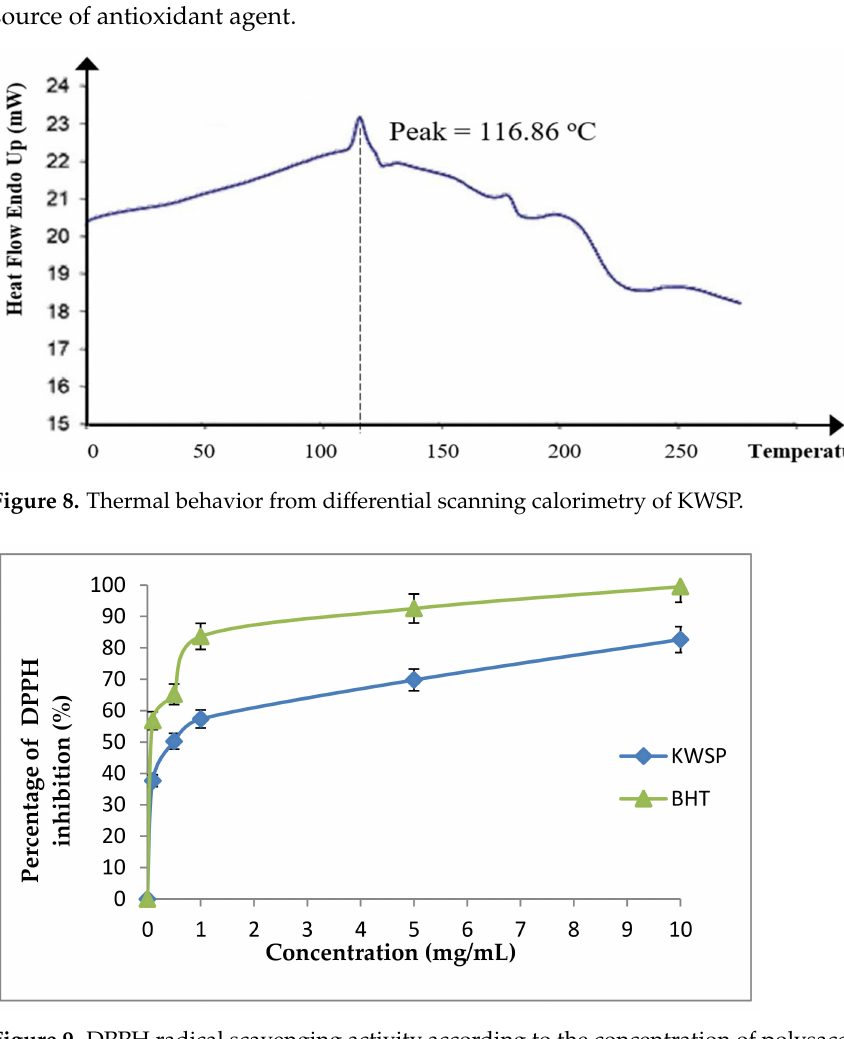
Figure 9. DPPH radical scavenging activity according to the concentration of polysaccharide. Each point represents the mean of three independent experiments (SD < 10% of the